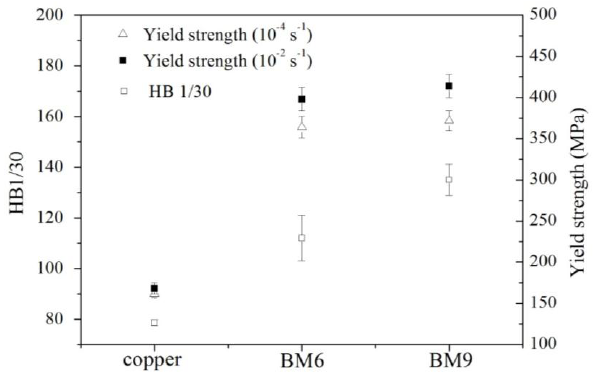
Figure 9. Brinell hardness and yield strength of the composites and copper.